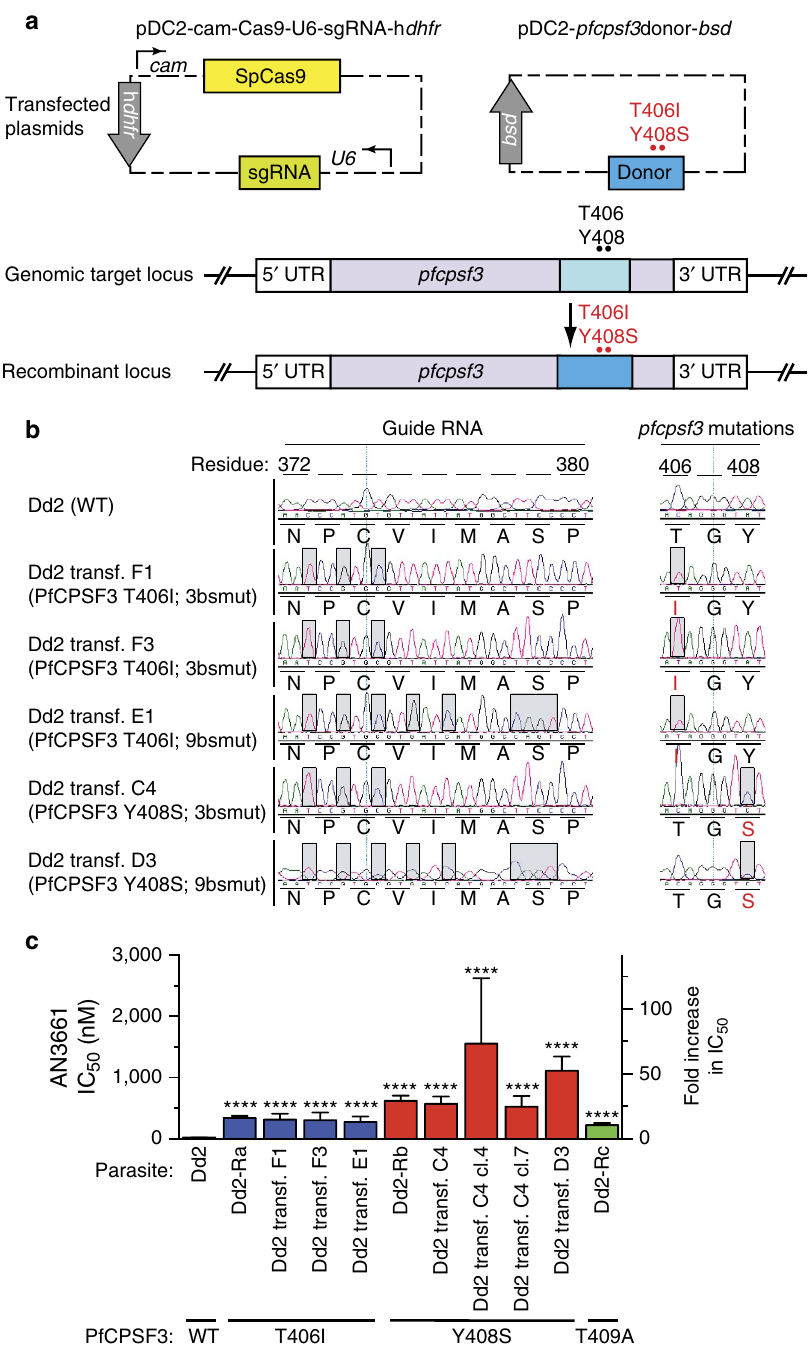
Figure 5 | CRISPR-Cas9-mediated pfcpsf3 editing. ( a ) Dd2 parental (WT) parasites were transfected with a dual-plasmid strategy in which one plasmid encoded the sgRNA, Cas9 nuclease and a h dhfr selectable marker, and the other plasmid encoded a donor sequence containing either the T406I or Y408S PfCPSF3 mutations (in red), as well as synonymous mutations in the sgRNA-binding region. ( b ) Electropherograms showing unmodified Dd2 and genome-edited parasites. Grey boxes highlight nucleotides that differ from WT parasites. PfCPSF3 single-letter amino acid substitutions are indicated in red. ( c ) Susceptibility to AN3661 of the parental line (Dd2 WT), parasites selected in vitro (Dd2-Ra, Dd2-Rb and Dd2-Rc), and genetically modified lines (Dd2 transf. F1, F3, E1, C4, C4 cl.4, C4 cl.7 and D3; replicates: Dd2 WT, 27; Dd2-Ra, 9; Dd2 transf. F1, 4; Dd2 transf. F3, 4; Dd2 transf. E1, 4; Dd2-Rb, 11; Dd2 transf. C4, 5; Dd2 transf. C4 cl.4, 2; Dd2 transf. C4 cl.7, 2; Dd2 transf. D3, 9; Dd2-Rc, 3.). Assay details are in Supplementary Table 1. Bar graphs represent mean ± s.e.m. IC 50 values. The black bar denotes PfCPSF3 WT, blue bars T406I, red bars Y408S and green bar T409A. Significance was determined using a two-tailed unpaired t -test, comparing transfected parasites with the parental Dd2 strain. **** P o 0.0001. NATURE COMMUNICATIONS|8:14574|DOI: